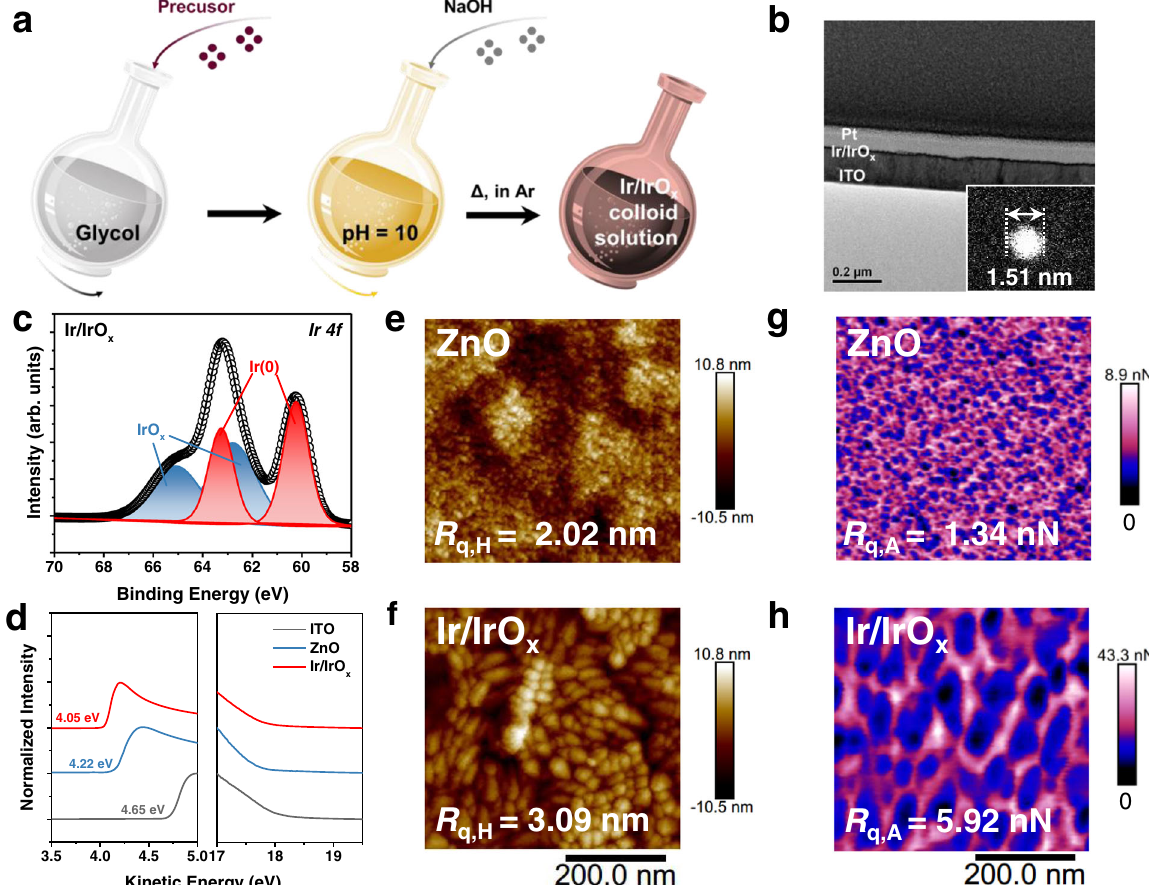
Fig. 1 | Characterization of Ir/IrO x . a The synthesis process of Ir/IrO x nano- particles. In the synthesis route, the Δ represents heating at 160°C. b The cross- sectionaltransmissionelectronmicroscope(TEM)patternsofIr/IrO x samplesspin- coated on ITO, which was prepared by a focused ion beam (FIB). The insert is